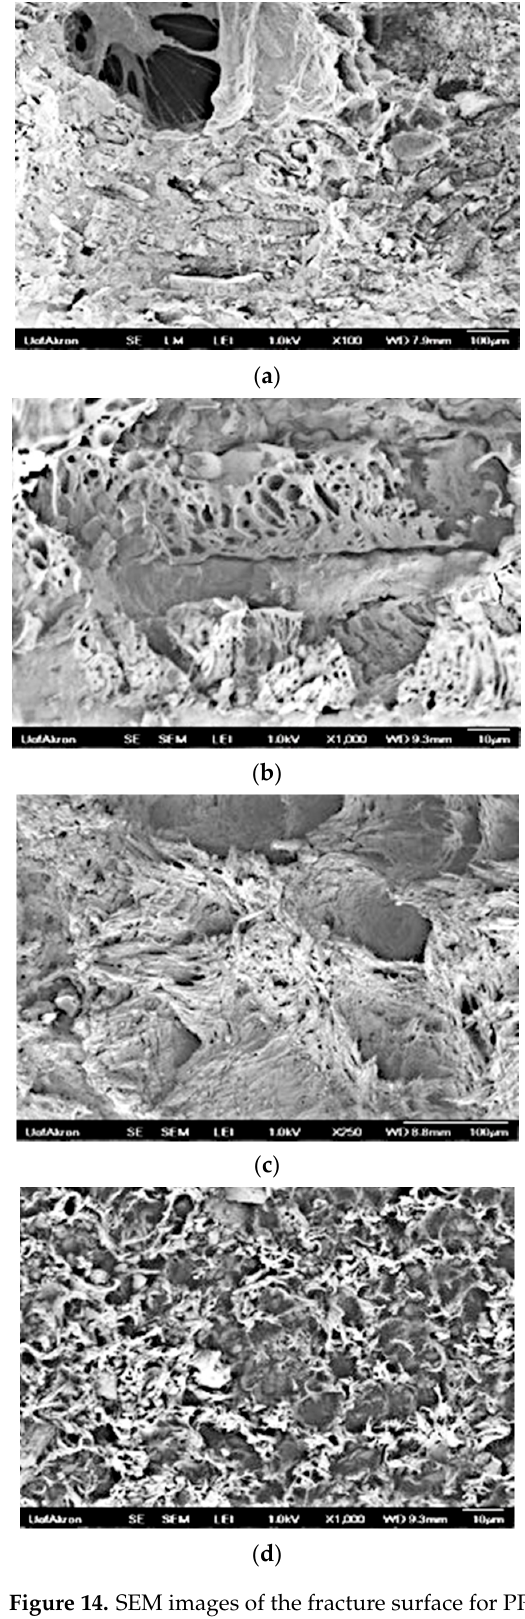
Figure 14. SEM images of the fracture surface for PP composite samples with: ( a ) 20 wt.% PSBH-A (X100); ( b ) 20 wt.% PSBH-A (X1000); ( c ) 20 wt.% GSBH-A (X250); and( d ) 20 wt.% GSBH-A (X1000).